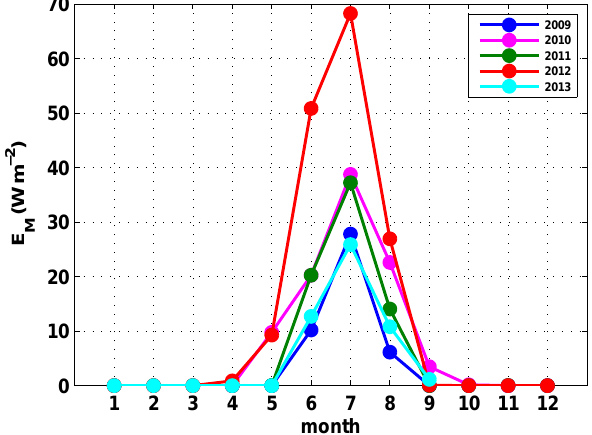
Figure 8. Seasonal cycle for the years 2009–2013 based on monthly averages of energy consumed by